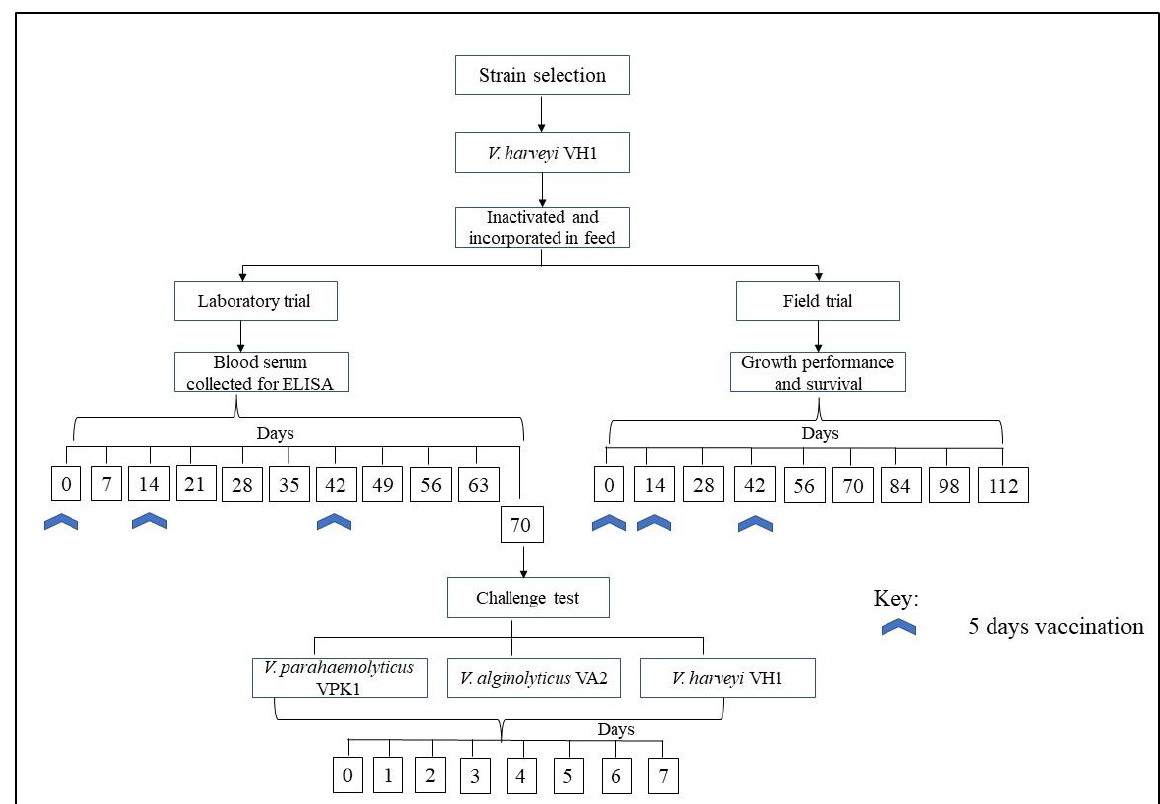
Figure 1. Overall graphical representation on strain selection, vaccine preparation and vaccination, and sampling schedule.